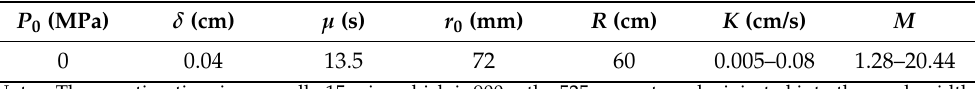
Table 4. Basic parameters